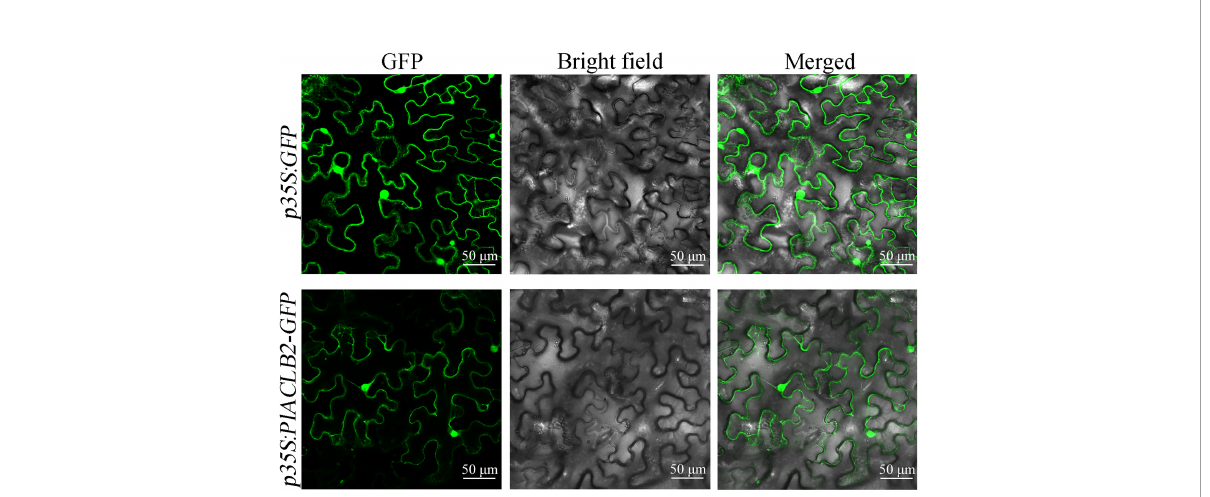
FIGURE 5 Subcellular localization of PlACLB2 in tobacco leaves. The green fl uorescences driven by p35S:GFP and p35S:PlACLB2-GFP were visualized at 488 nm